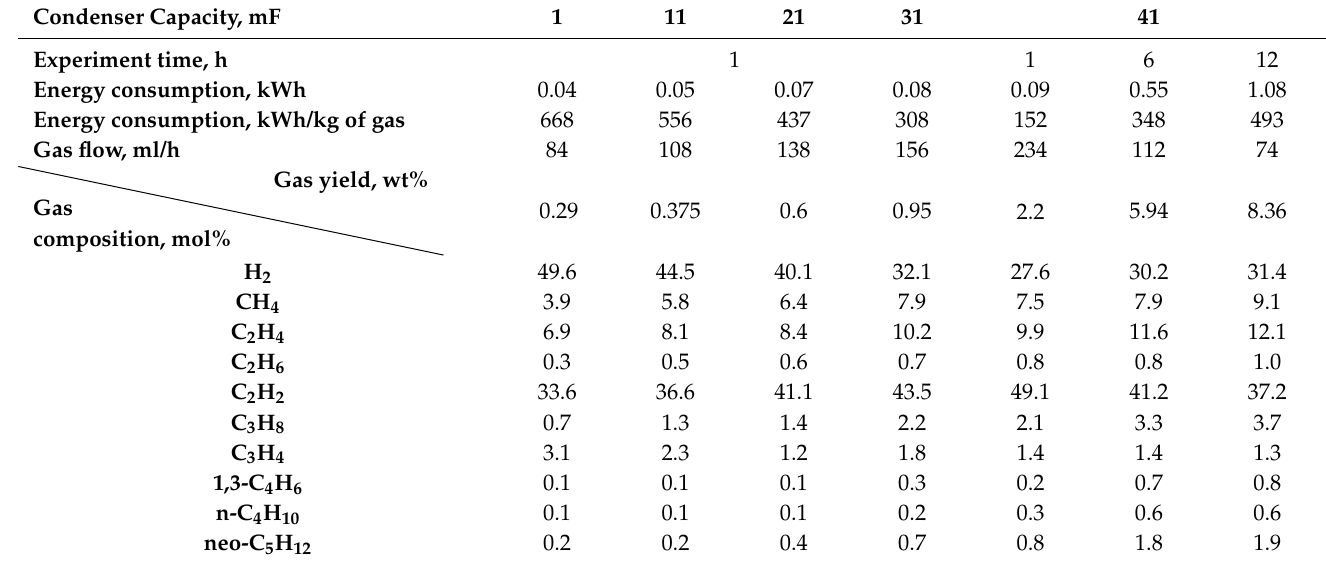
Table 2. Characteristics of NTP pyrolysis of fuel oil and composition of gaseous products.